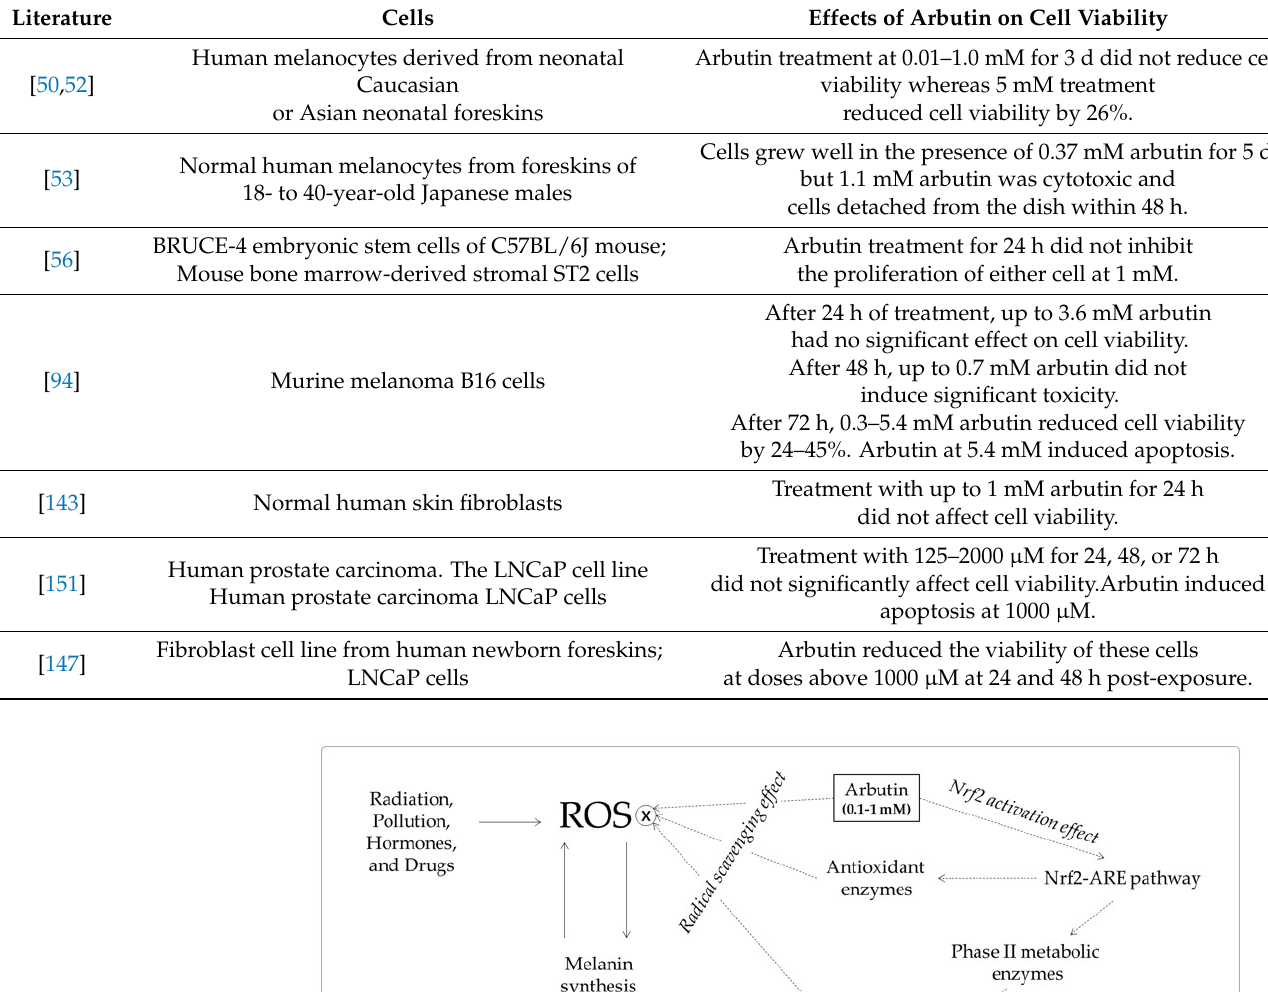
Table 5. Effects of arbutin on the viability of different cells.